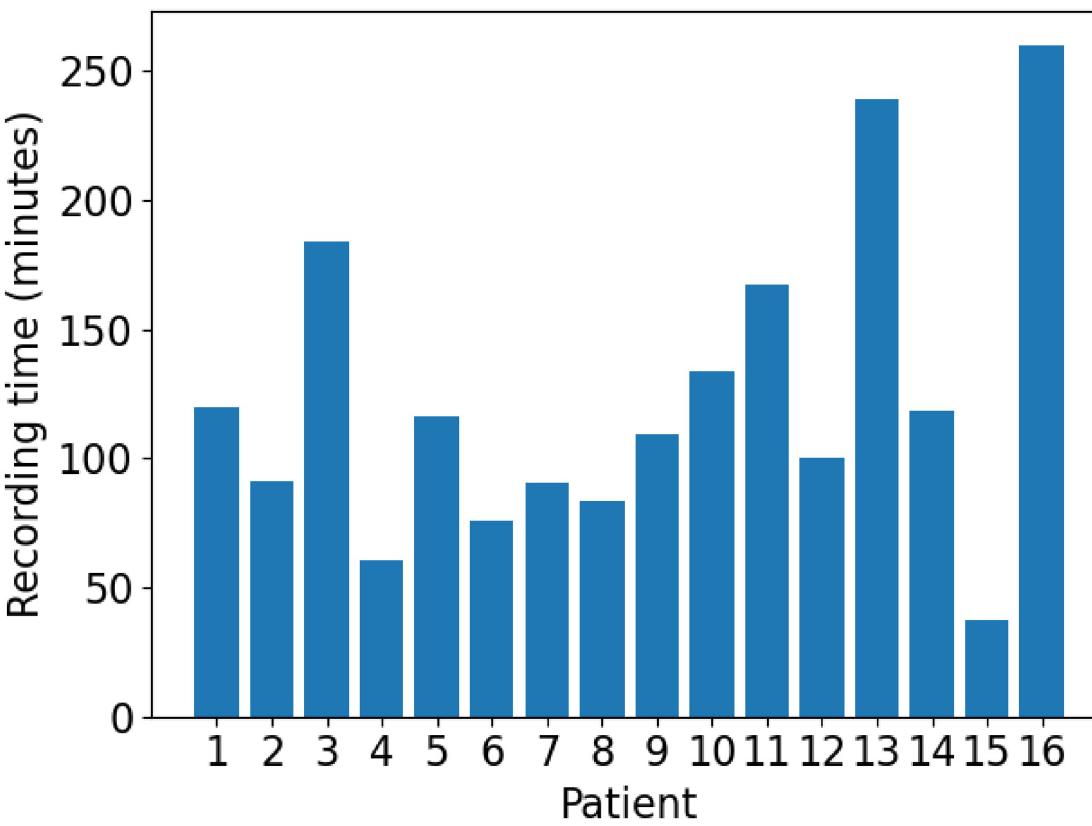
Fig 5. UWM dataset recording times. Total time in minutes of EEG included for each patient in the UWM dataset.